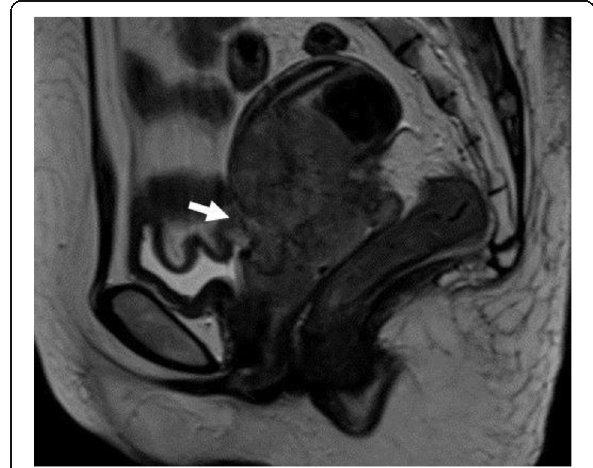
Fig. 5 T2W MRI sagittal view showed bladder invasion demonstrated as disruption of normal hypointense urinary walls without a mass protruding into the lumen